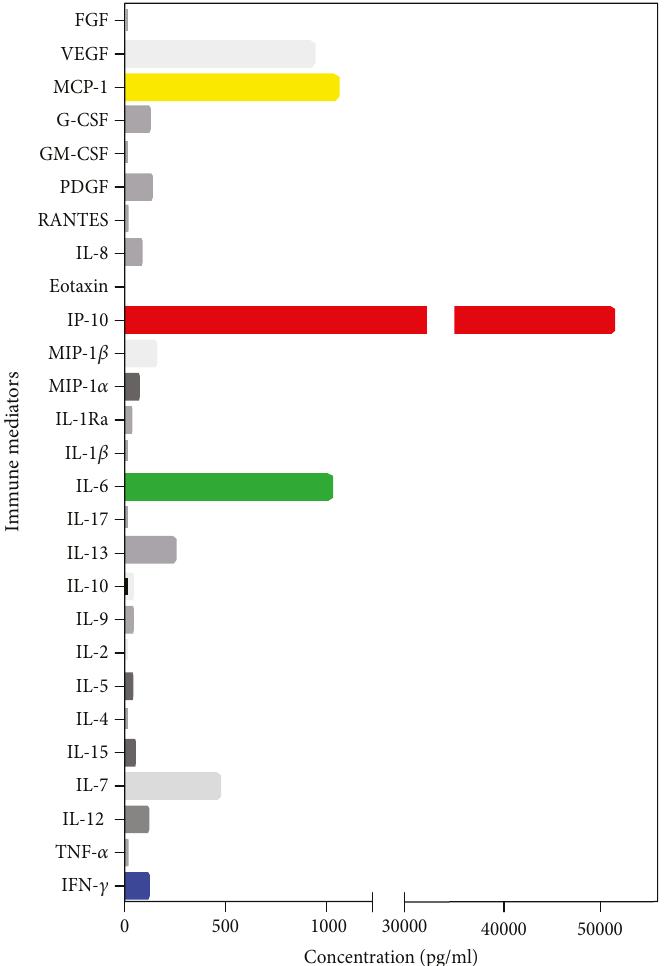
Figure 6: Bar graph showing the pro fi le of immune mediators in aqueous humor of a patient with congenital recurrent OT who had 2 recurrences with low IFN- γ levels, but high levels of IP-10, IL-6, MCP-1, and